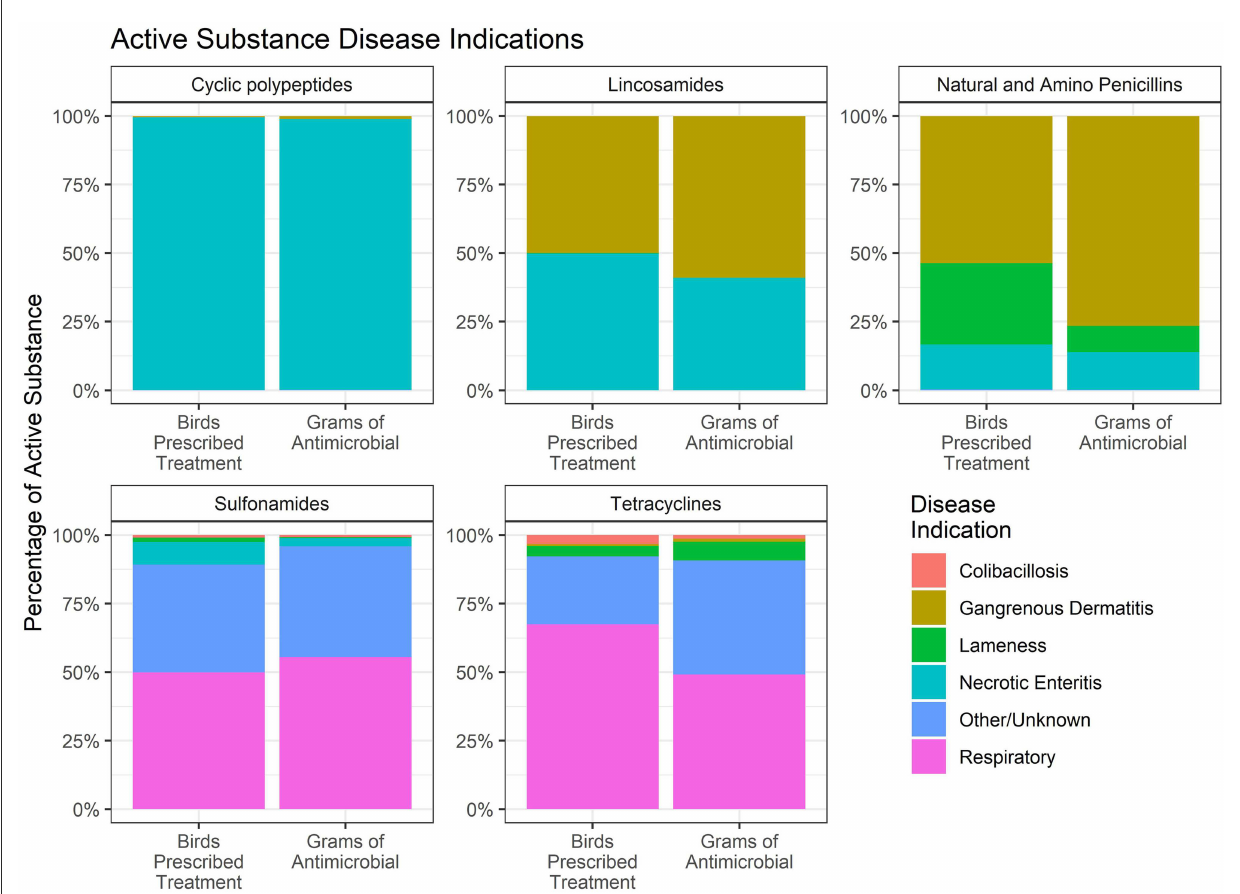
FIGURE11 Percentage of antimicrobial use in the water of broiler chickens by disease indication, 2018–2021. Each figure only includes data for those birds that received the given antimicrobial. The figures depict the percentage of birds receiving therapy with the given antimicrobial (Birds Prescribed Treatment) and the percentage of total grams of the antimicrobial used by disease indication (Grams of